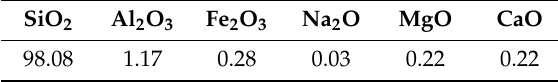
Table 2. Composition of silica sand (wt.%).